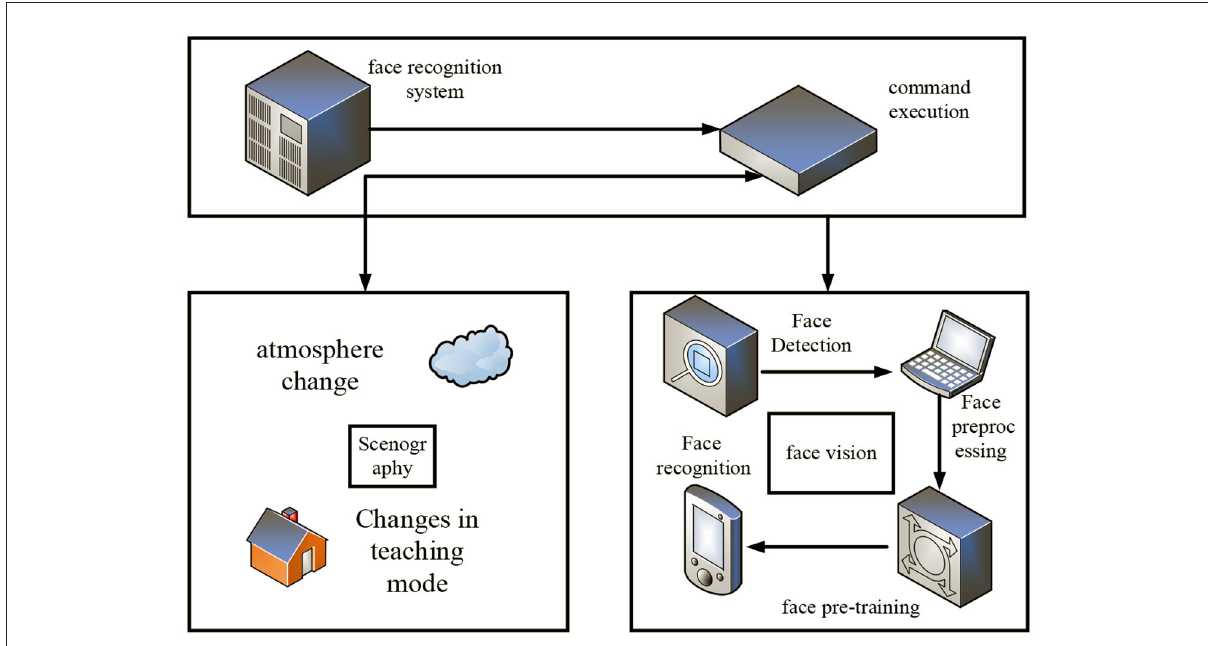
FIGURE4 Module diagram of emotion recognition system based on